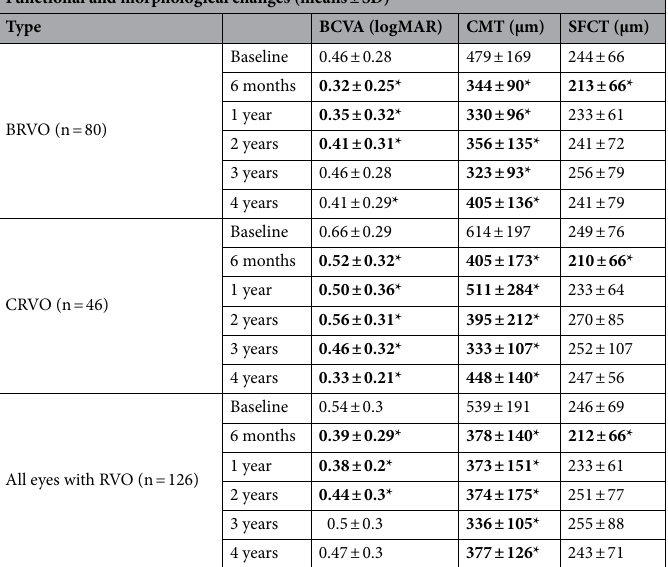
Changes of BCVA in logMAR (means ±